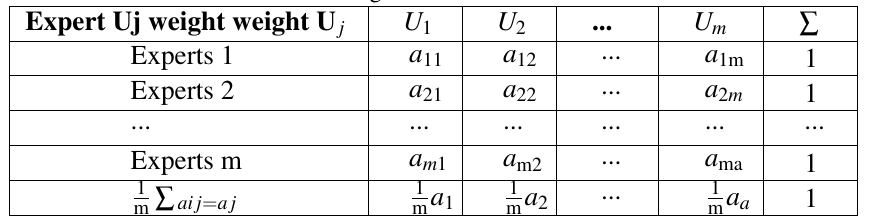
Table 2 Weight determination